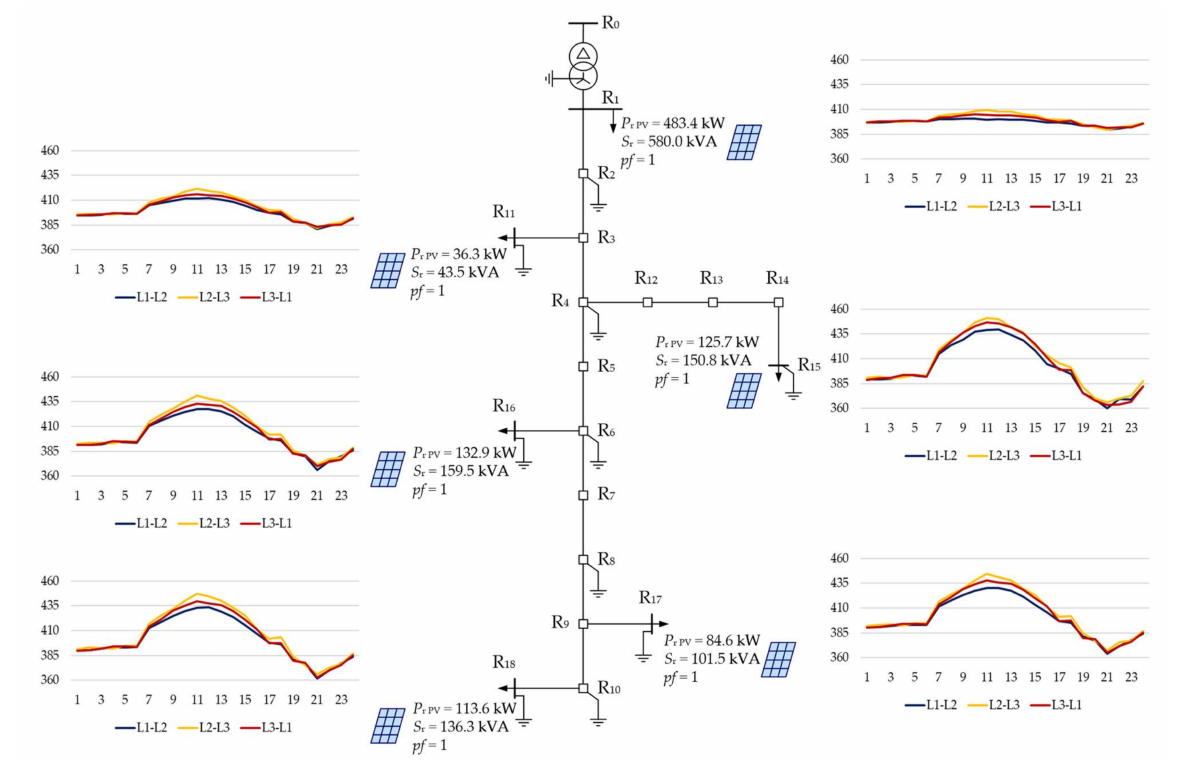
Figure A13. Daily simulation results for variant V10: phase-to-phase voltages (V).